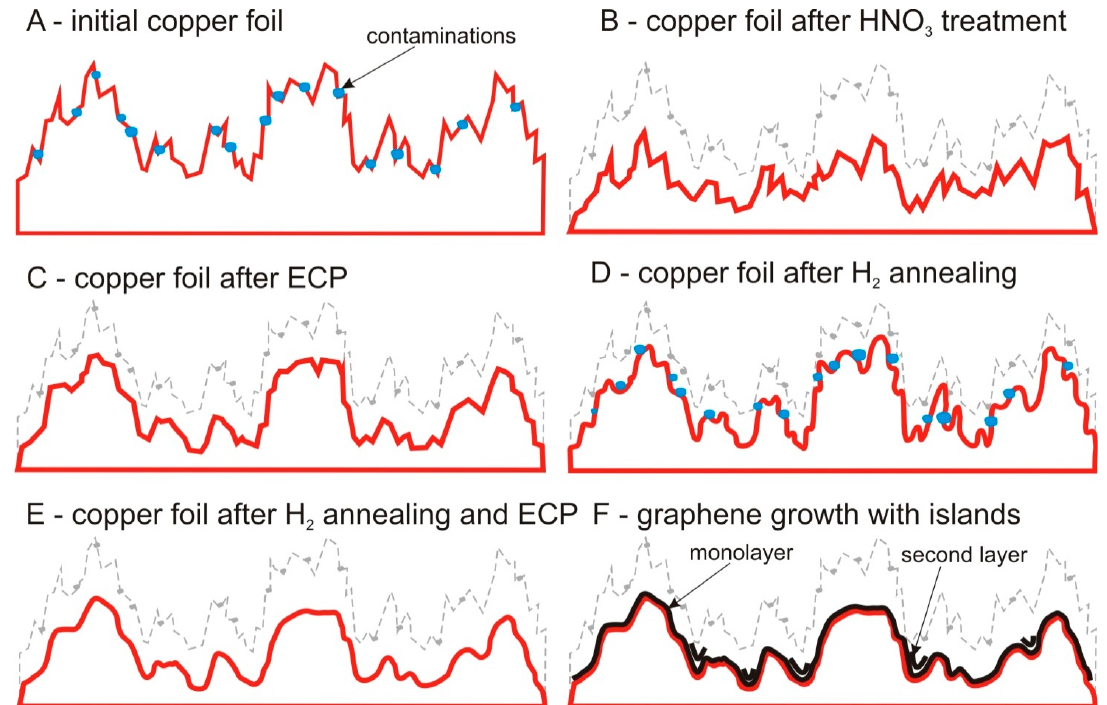
Figure 3. Principle scheme of a change in the copper surface roughness during various treatments ( A–E ) and formation of graphene layers ( F ).